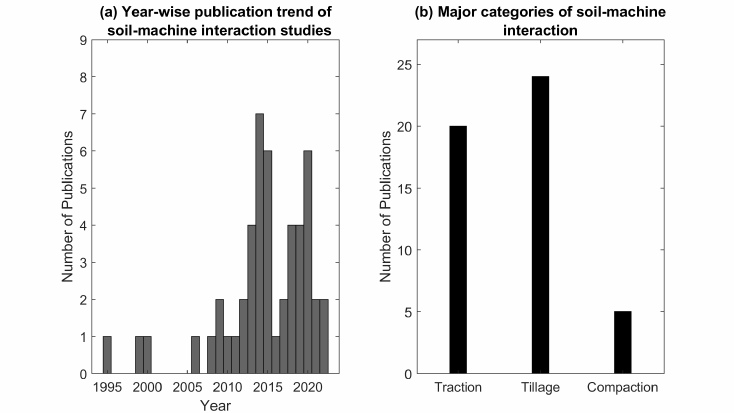
Figure 14. Soil–machine interaction studies that employed CI methods: ( a ) Year-wise publication trend; ( b ) Major